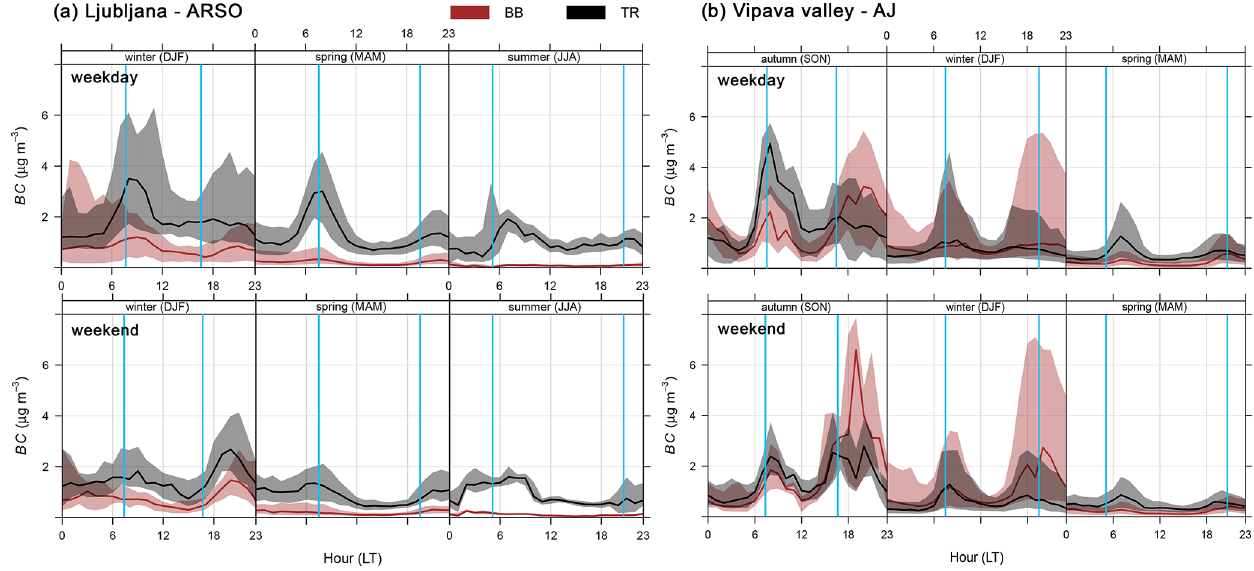
Figure 5. Diurnal variation (local time: CET/CEST) in source-specific black carbon concentration (traffic – TR and biomass burning – BB) at Ljubljana urban background – ARSO (a) and Vipava valley urban background – AJ (b) , grouped by season and weekday or weekend. The statistics for every hour in a day are represented by the median value (line) and 25th–75th percentiles (shaded area) derived from 1min data. AAE TR and AAE BB were set to 1 and 2, respectively. Blue vertical lines mark the sunrise and sunset time.